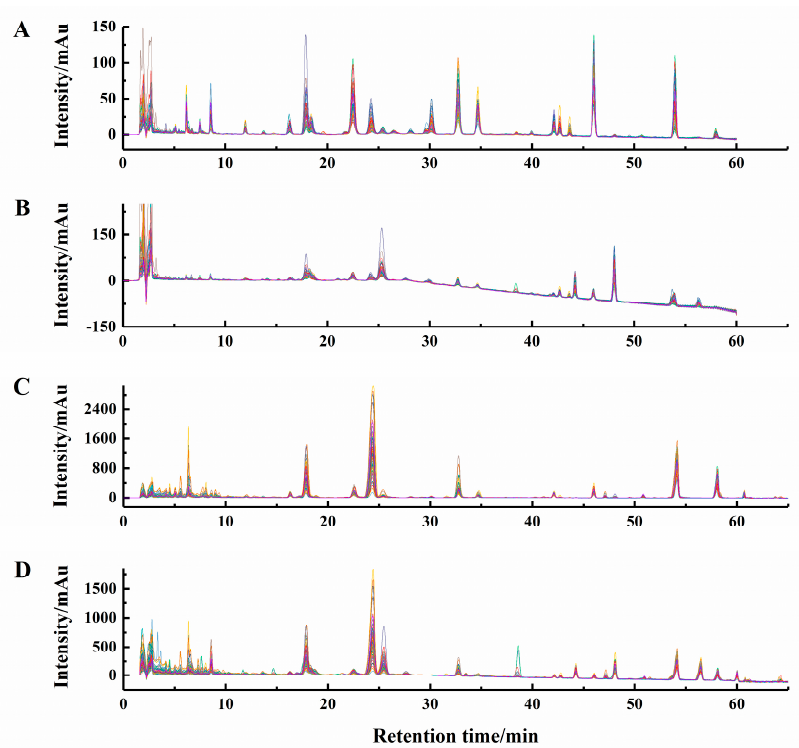
Figure 3. Chromatograms of Poria ( A , B ) and Poriae Cutis ( C , D ) recorded at 242 ( A , C ) and 210 nm ( B , D ) after the transformation of correlation optimized warping.